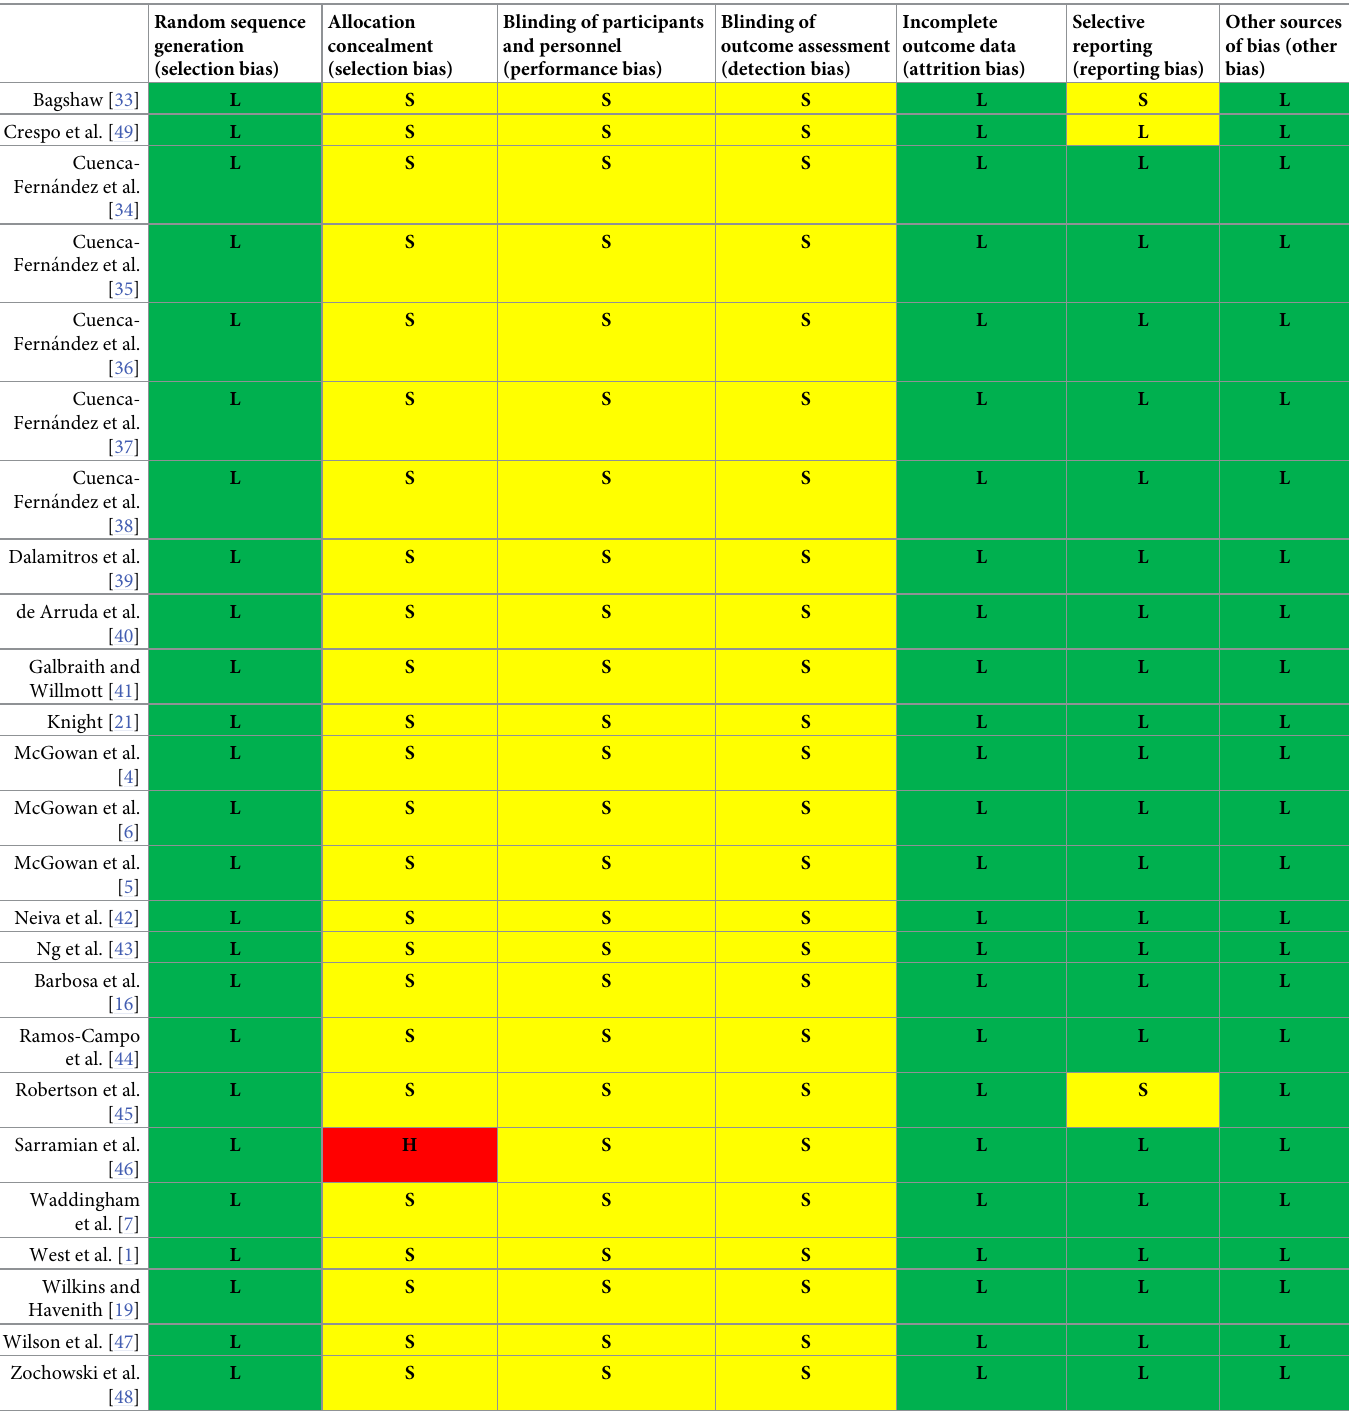
Table 8. Risk of